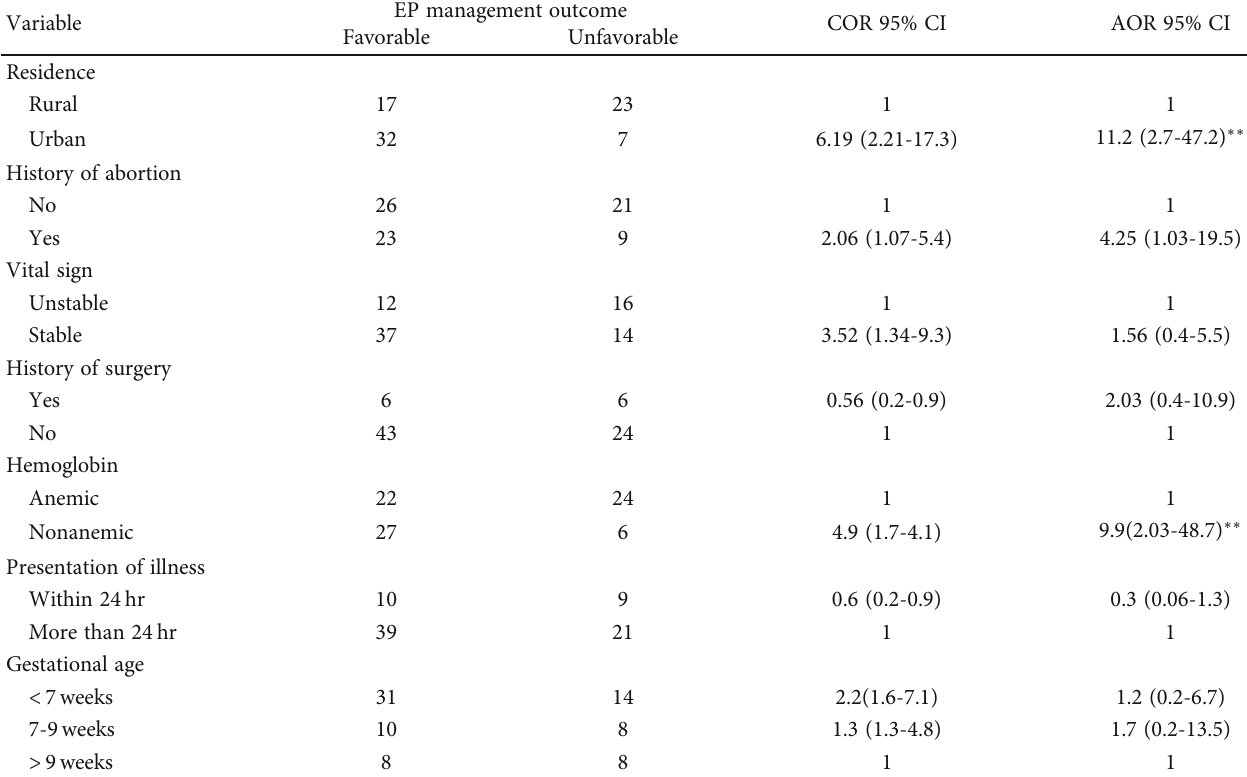
∗ For variables showing signi fi cant association during multivariate analysis at p < 0 : 05